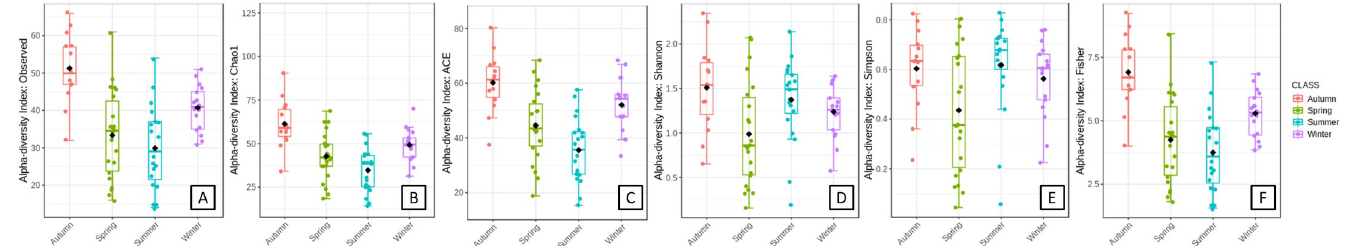
Fig 9. Comparison of alpha diversities of nasal bacterial communities of health care professionals stationed in a health care laboratory (A) Observed (B) Chao1 (C) ACE (D) Shannons (E) Simpsons (F) and Fisher. The boxes represent the range of alpha diversity within the samples in a particular season. Corresponding alpha diversity values are plotted on Y-axis. All the comparisons were done employing one way ANOVA at p � 0.05.